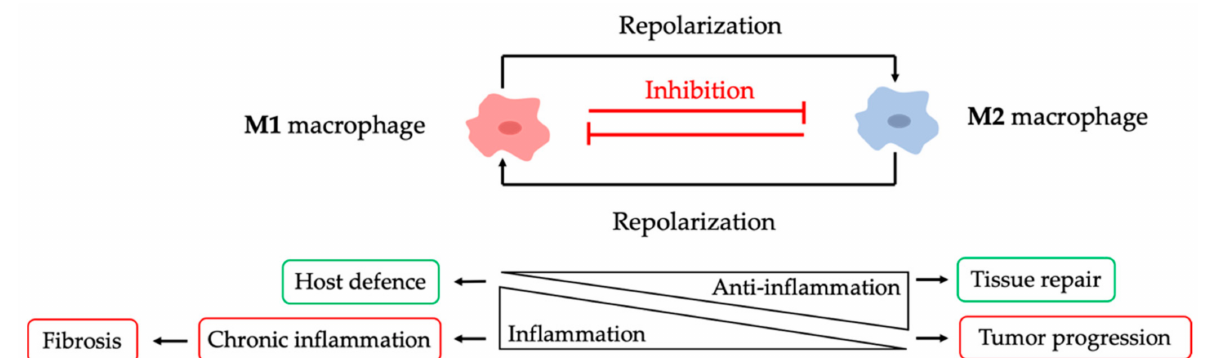
Figure 3. Macrophage roles on host defense. Macrophages are commonly divided into two phenotypes: M1 and M2 macrophages. These phenotypes are reversible, and macrophages can be re-programmed depending on the local stimuli. The inflammatory and anti-inflammatory responses carried out by macrophages need to be well balanced to prevent disease. Uncontrolled M1 macrophage activation can lead to chronic inflammation and un-controlled M2 macrophage activation can lead to tumour